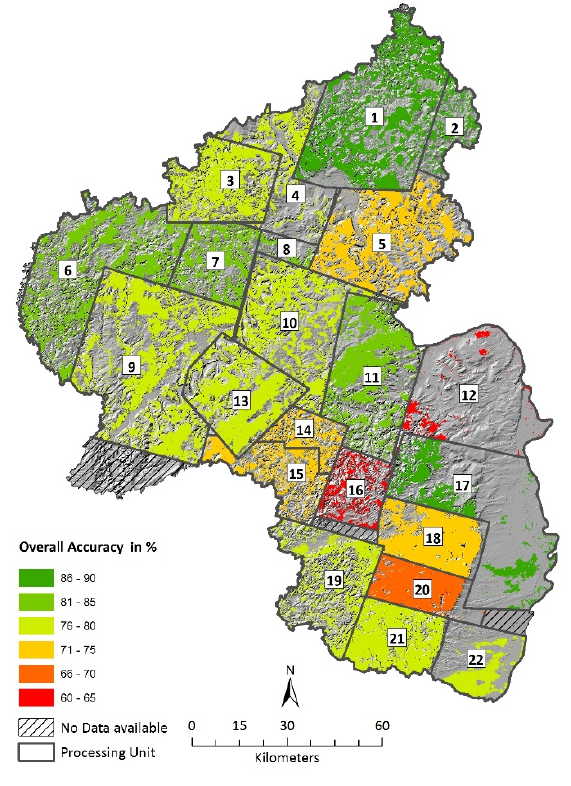
Figure 8. Overall classification accuracy at tree species level for each of the 22 processing units. Compared with the overall classification accuracy of 83.5% for the whole study area, unit-based accuracy ranges from 69% (unit 17) to 87% (units 1 and 17); 16 of the 22 processing units achieve overall accuracies >75%, corresponding to 70.6% of total forested area within the state. A further three processing units obtained accuracies >70%, and only three units had overall accuracies <70%. Nonetheless, Figure 7 shows distinct regional differences in the mapped processing units. To determine the causes of quality deficiencies, Table 5 summarizes the characteristics of each processing unit and their respective accuracies. See Supplementary Information 2 for more details about the proportional coverage of the five main tree species according to the official forest inventory